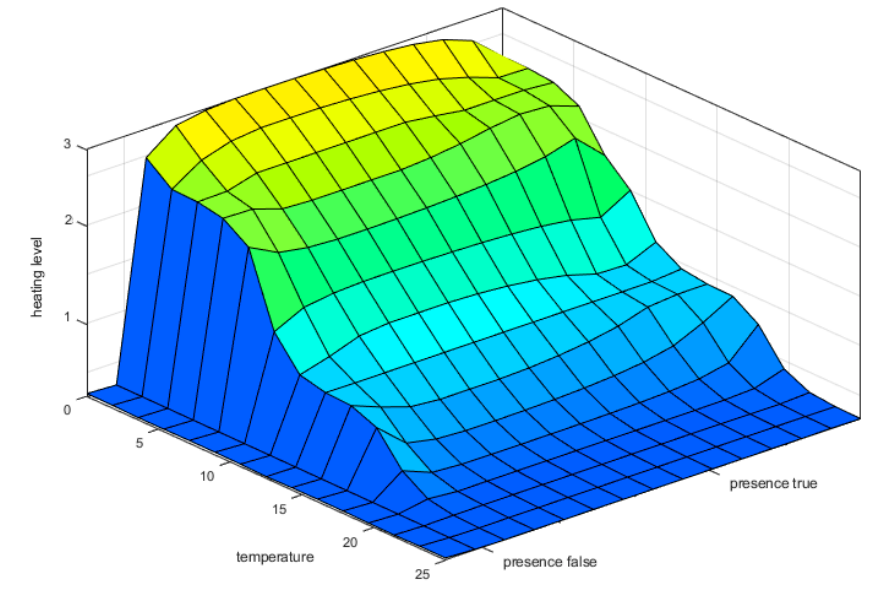
Figure 5. Heating level dependency on temperature and presence.